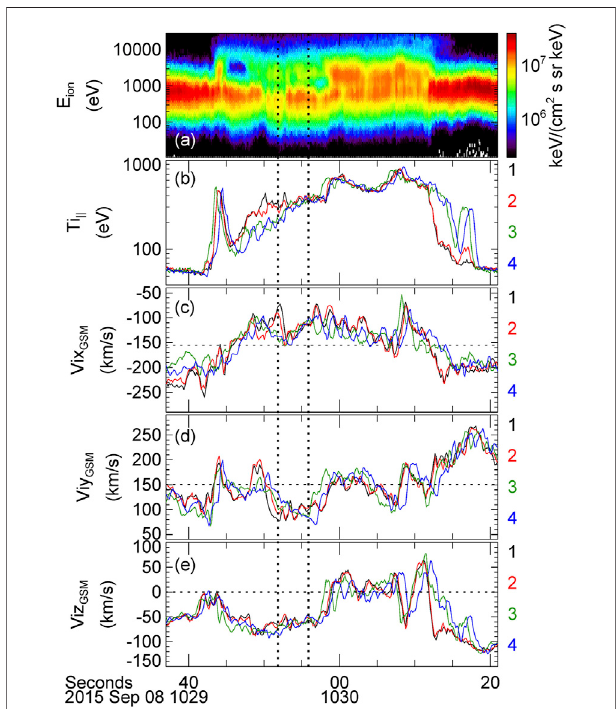
FIGURE5| MMSobservationsinburstmodefrom1029:37UTto1030: 21 UT on 8 Sept 2015: (A) MMS-1 ion omni-directional energy-time spectrogram; (B) ion parallel temperature; (C – E) ion velocity components in the GSM coordinate system. Panels (B – E) display MMS-1 observations in black, MMS-2 observations in red, MMS-3 observations in green, and MMS-4 observations in blue color. The two vertical dotted lines mark a time period 1029:51.849 – 1029:55.900 UT with two counter-propagating ion beams in MMS-1 ion VDFs. The horizontal dotted lines mark the average Vx GSM (cid:1) − 155.37 km/s (panel C ) and the average Vy GSM (cid:1) 150.68 km/s (panel D ).